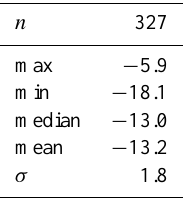
Table 2. δ 18 O summary statistics (‰) for the upper 17m ice core depth, representing the time period